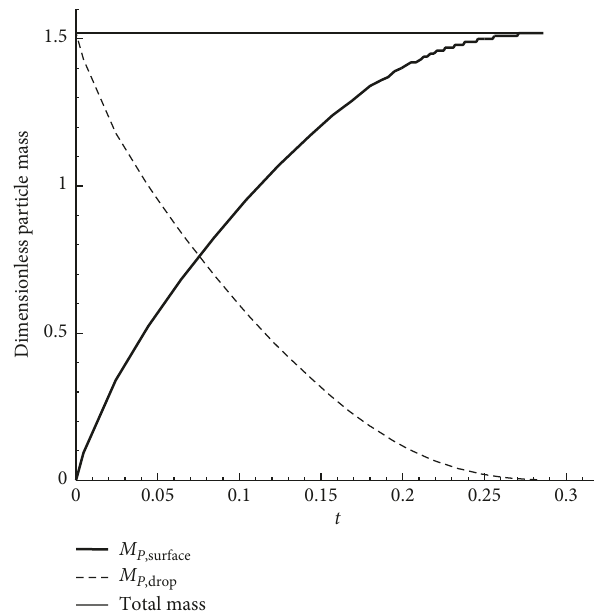
Figure 7: Curves of particle mass versus time in the different phases: on the substrate, in the drop phase, and the sum of the two (Pe � 1, Da � 10. Initial AR � 0.8, Ca � 8.41 × 10 − 8